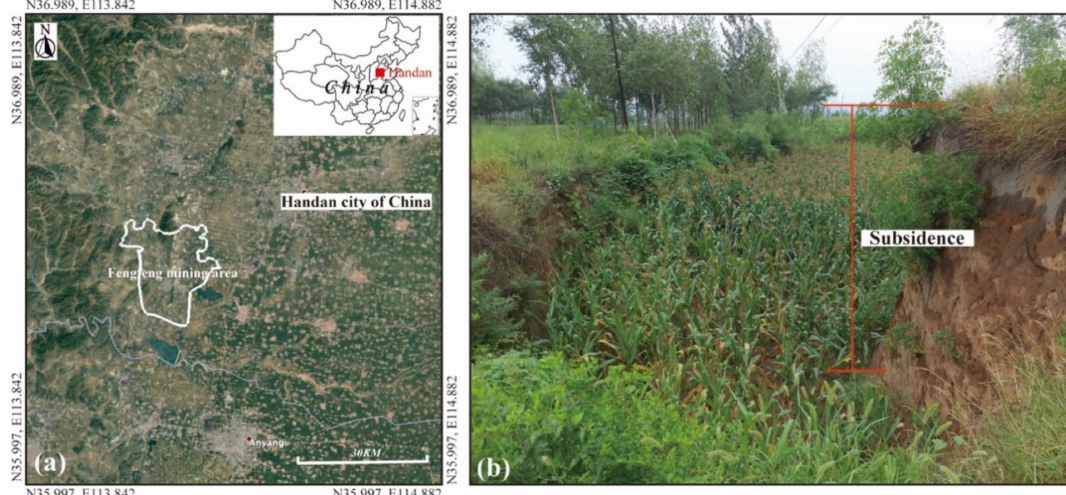
Figure 1. ( a ) Geolocation of the Fengfeng mining area, framed by the white polygon; ( b ) the picture of the field mining area indicates large subsidence and dense ground vegetation.